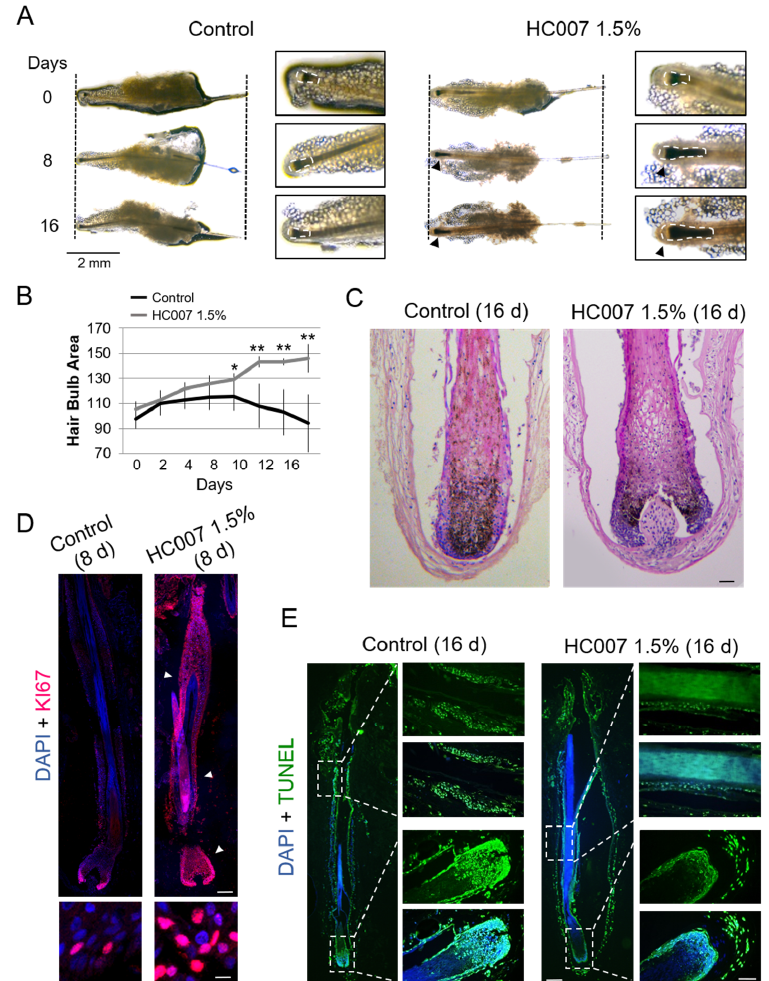
Figure 1. Sustained maintenance of human hair follicle growth ex vivo in a defined glycosaminoglycan hydrogel matrix (HC007). ( A ) Representative phase-contrast microscopy images of whole hair follicles showing significant thickening (black arrowheads) of the hair bulb area, defined here as an area encompassing hair bulb/dermal papilla and suprabulbar regions, after continuous growing in HC007 1.5%. Vertical dotted lines delimitate hair follicle length at time 0. A noticeable length increase in hair follicle length was observed in 50% of the HC007 1.5% samples. Enlarged images depicting typical hair bulb areas used in image quantification analysis (white dotted lines). Bar: 2 mm. ( B ) Time course quantification of hair bulb area in control and HC007 1.5% samples. Results are representative of at least 18 hair follicle units per condition. The mean +/ − SD of n ≥ 18 for each experimental condition is represented and t -test was used for statistical analysis. *, significant p ≤ 0.1. **, significant p ≤ 0.05. ( C ) Representative histological sections stained with H&E of the hair bulb area in control and HC007 1.5% after 16 days in culture. Bar: 50 µ m. ( D ) Confocal microscopy images (maximum projections) sections of hair follicles grown ex vivo for 8 days in control basal culture conditions or in HC007 1.5%. Bar: 100 µ m. Enlarged images show nuclear KI67 staining in outer root sheath cells. Bar: 10 µ m. sections of hair follicles grown ex vivo for 16 days in control basal culture conditions or in HC007 independent